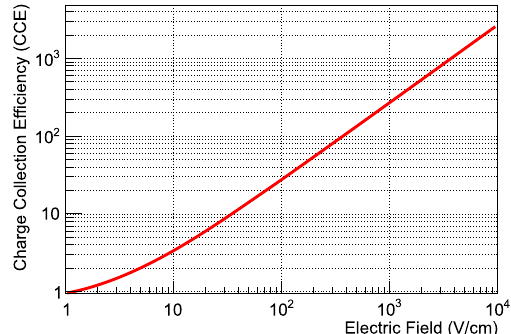
Fig. 9 Shown is the predicted CCE as a function of applied electric field